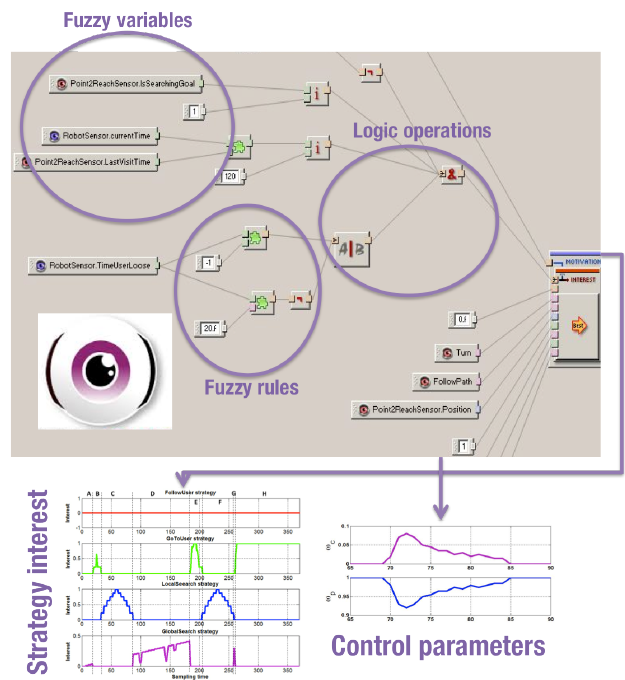
Figure 4. Examples of human detection. Top: a person walking and speaking in zone 2; he is detected by all the detectors (confidence value=1). Bottom: 2personsinzone3; oneisspeakingandisdetectedbyboth upper body and sound detector (confidence value=1), the other one just by the upper body detector (confidence value=0.75).